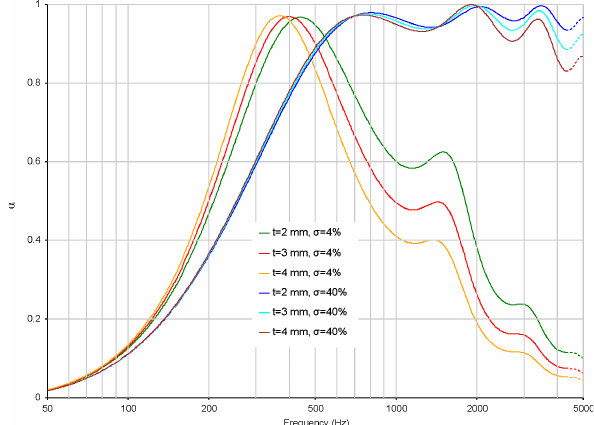
Figure 16: Influence of the plate thickness (0.5 mm air gap)